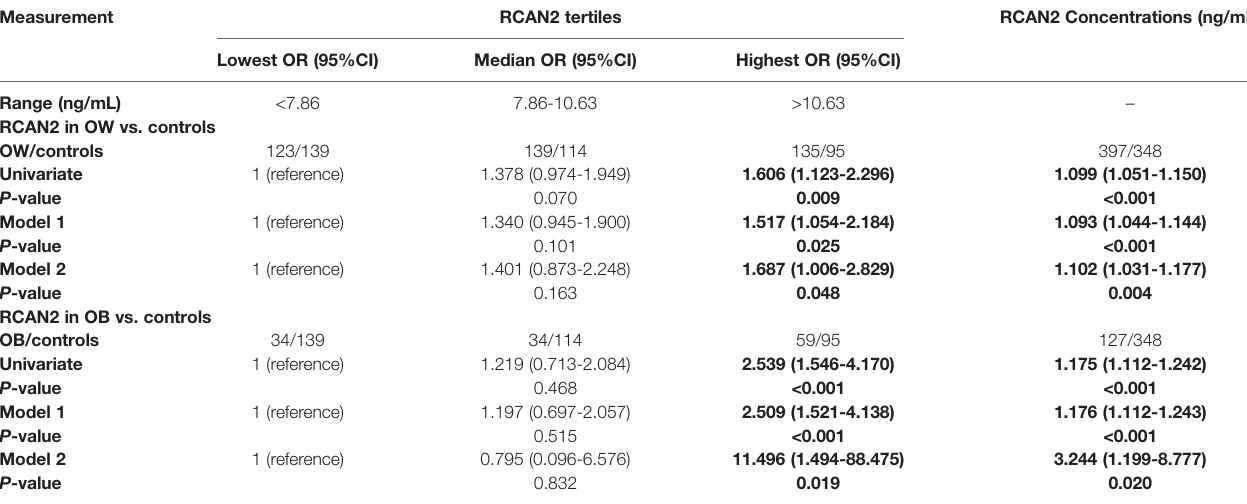
TABLE 2 | Unconditional logistic regression analysis of overweight and obesity risks according to the tertiles of serum RCAN2 concentrations and serum RCAN2 concentrations (ng/mL). Measurement RCAN2 tertiles